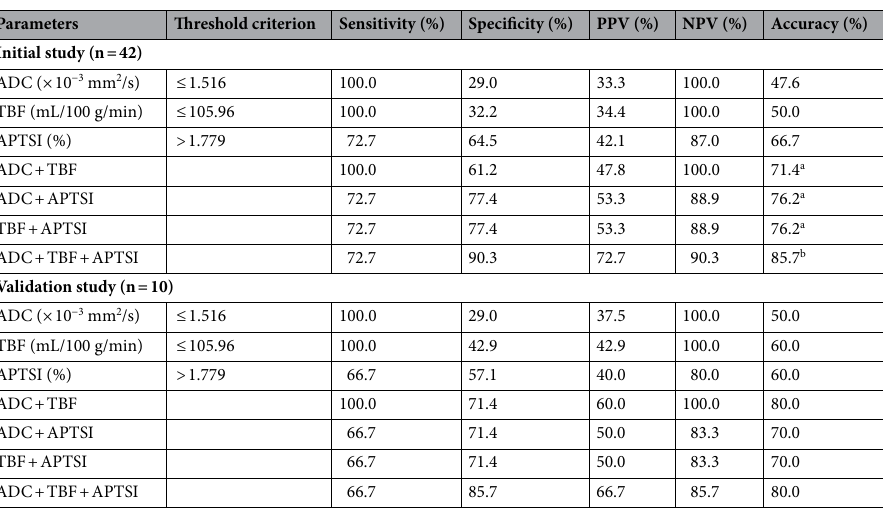
Table 3. Performance of MR parameters for diagnosing malignant salivary gland lesions. ADC, apparent diffusion coefficient; TBF, tumor blood flow; APTSI, amide proton transfer related signal intensity; PPV, positive predictive value; NPV, negative predictive value. a Significant difference in comparison with ADC alone or TBF alone (p < 0.05). b Significant difference in comparison with each parameter (ADC or TBF or APTSI) alone (p < 0.05).